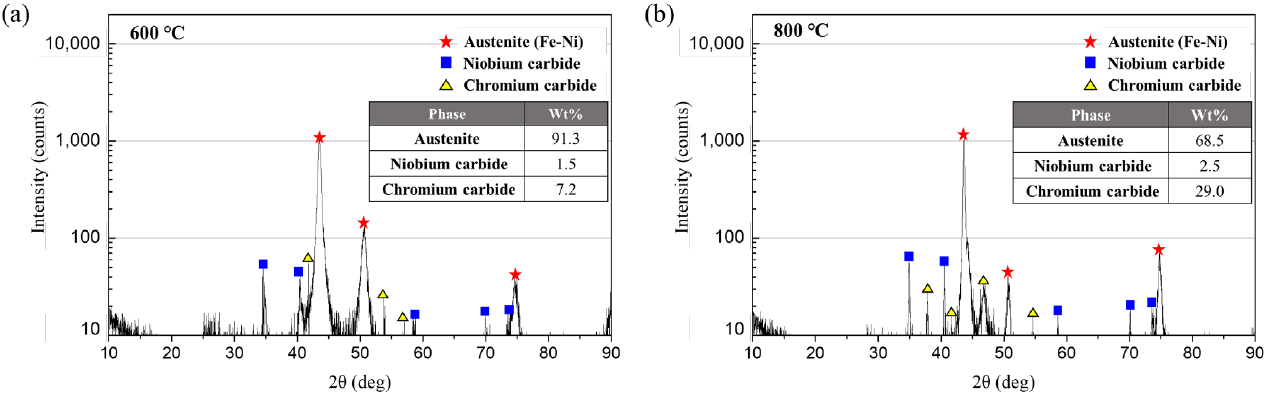
Figure 7. X-ray diffraction patterns and weight fraction of the phase of austenitic stainless steel with Nb; ( a ) LCF at 600 °C; ( b ) LCF at 800 °C.